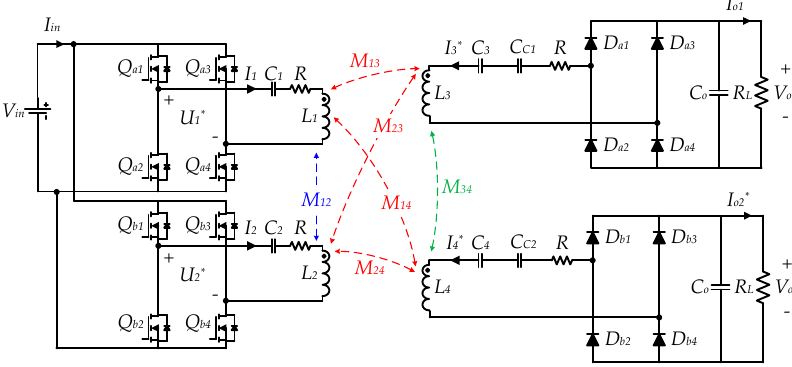
Figure 9. Multi-output omnidirectional wireless power transfer system circuit when adding canceling capacitors.